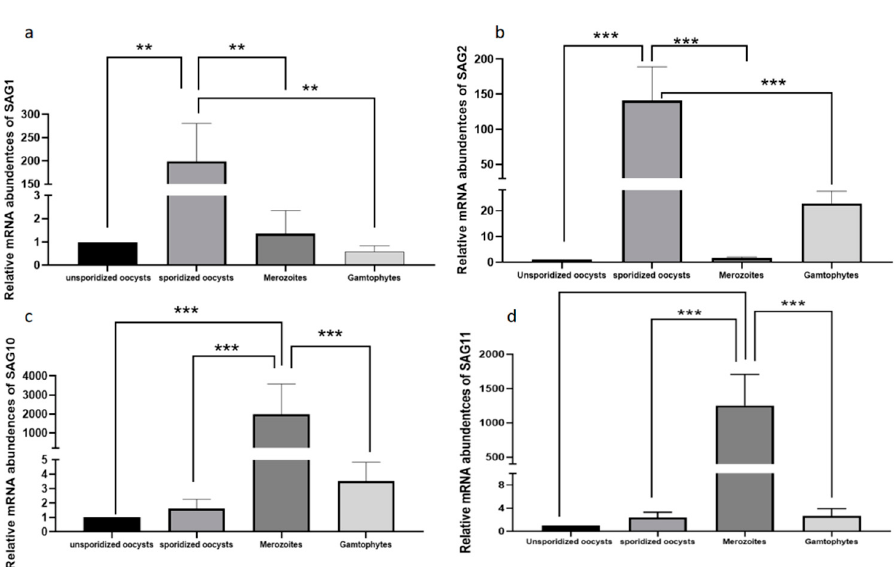
Figure 2. The relative transcriptional levels of EmSAGs at different developmental stages. ( a ) is the relative transcriptional levels of EmSAG1 at different developmental stages; ( b ) is the relative transcriptional levels of EmSAG2 at different developmental stages; ( c ) is the relative transcriptional levels of EmSAG10 at different developmental stages; ( d ) is the relative transcriptional levels of EmSAG11 at different developmental stages; Data are shown as mean ± SD of three replicates per group. ** p < 0.01, *** p < 0.001. All values were estimated by ANOVA (Duncan’s post hoc) at p ≤ 0.05.